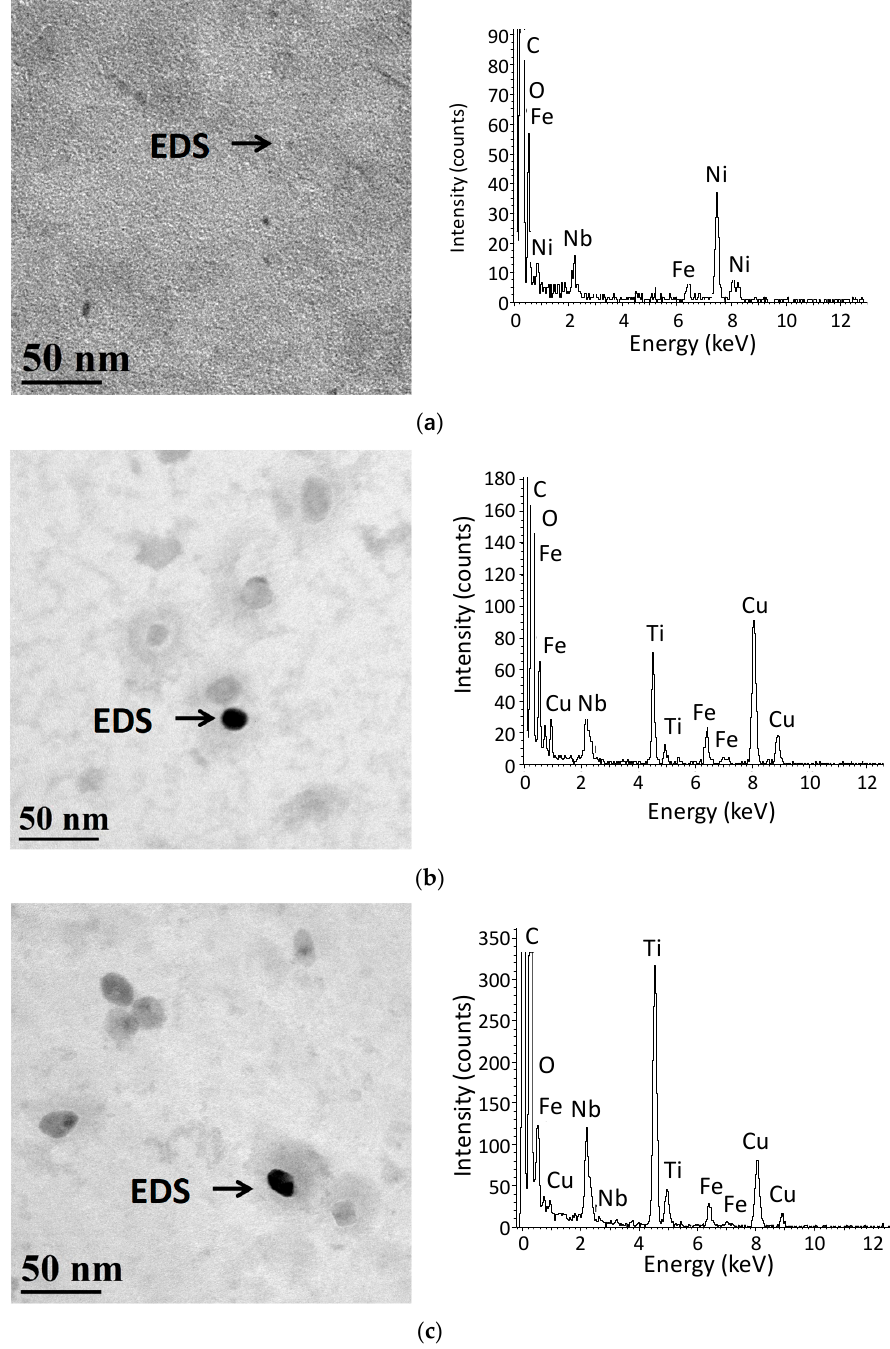
Figure 11. Strain-induced precipitates detected in the carbon replicas after deformation at 900°C and corresponding EDS analysis (tests performed with roughing, 𝜀 = 0.35, 𝜀(cid:4662) = 1 s − 1 and 100 s holding time). ( a ) Ti0Nb3 steel, D = 7.2 ± 0.2 nm, ( b ) Ti10Nb3 steel, D = 15.0 ± 0.4 nm, ( c ) Ti15Nb3 steel, D = 16.0 ± 0.5 nm.